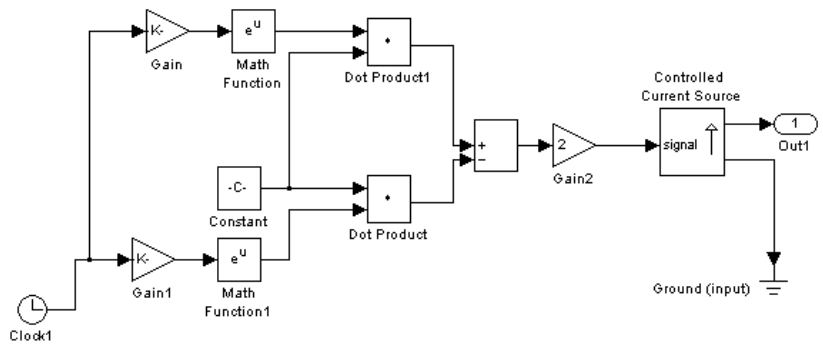
Fig. 3. Model for discharge current generator with possibility of striking amplitude regulation